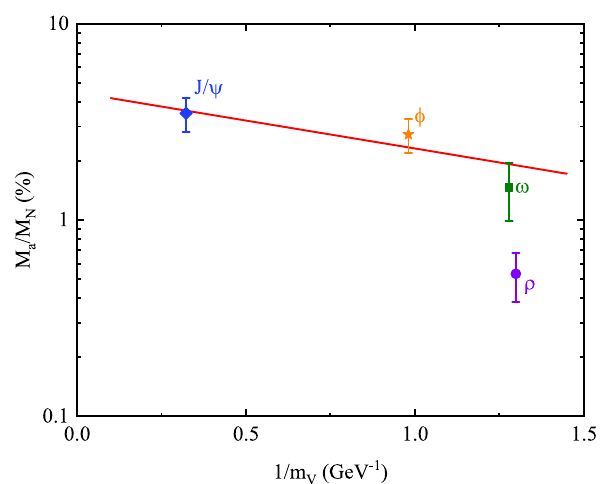
Fig. 7 The distribution of the trace anomaly contributions obtained from different vector mesons photoproduction. The blue diamond, the orangepentagram,theolivegreensquare,andthepurplecirclerepresent the results from J /ψ [51], φ , ω , and ρ ,